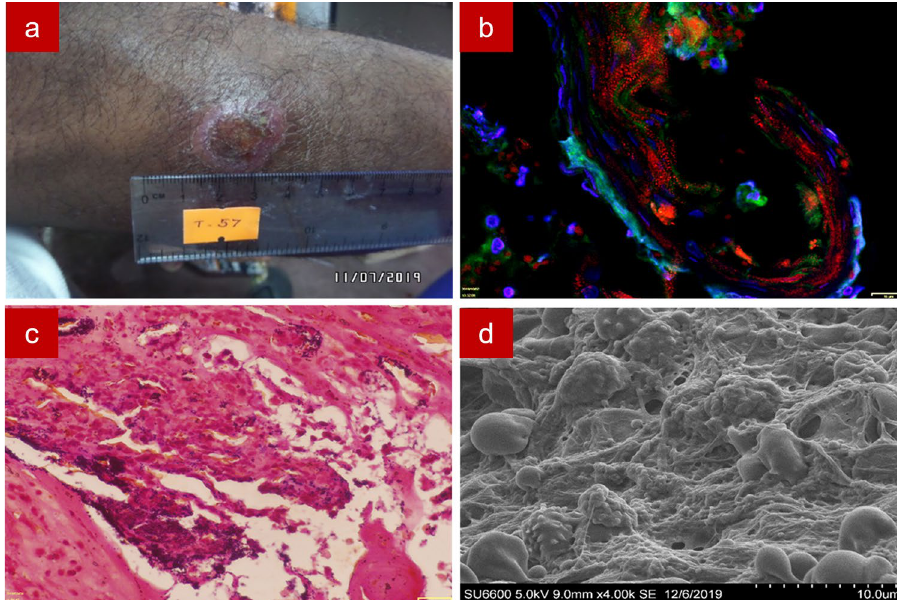
Figure 6. Sample 2. Image of a wet ulcer of 4 weeks duration with a yellow scab in the lower limb ( a ); Fluorescence in situ hybridization showing bacteria in red with the CY3 tagged Eu bacterial probe, extracellular polymeric substances in green with Concavalin A conjugated Alexa Fluor 488 and tissue nuclei in blue with DAPI ( b ); Gram staining showing gram-positive cocci in clumps ( c ); Scanning electron microscopy showing coccoid shaped bacteria embedded in thread-like extracellular polymeric substance ( d ).